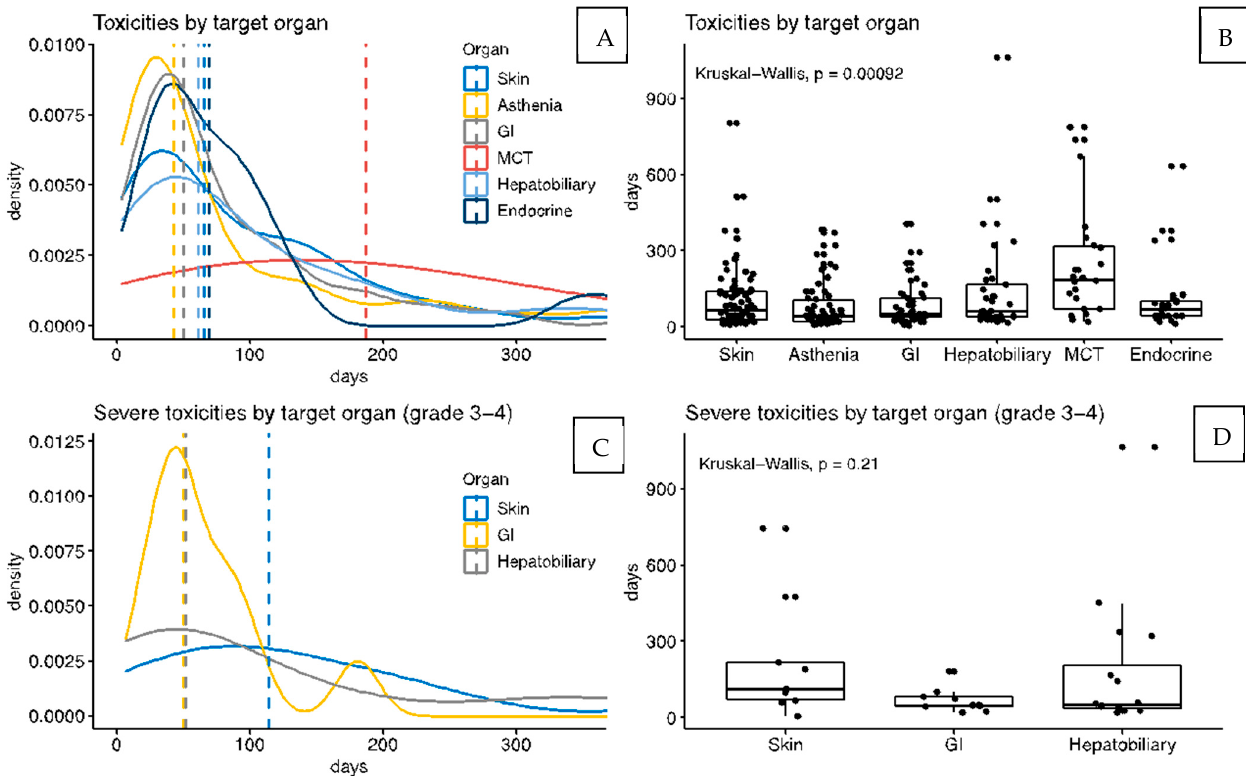
Figure 2. Density plot and boxplot toxicities. Box plots showing the percentages of patients who presented specific toxicities. Panel ( A , B ) show the frequency of immune-related adverse events (irAEs) stratified by target organs. Fever and asthenia were considered as target symptoms due to the frequency of these side effects. Panel ( C , D ) show the frequency of severe (grade 3–4) irAEs stratified by target organs. Abbreviations: EM, erythema multiforme; MCT, musculoskeletal and connective tissue; PPE, palmar-plantar erythrodysesthesia; NMSC, non-melanoma skin cancer; SSS, Stevens-Johnson syndrome; TEN, toxic epidermal